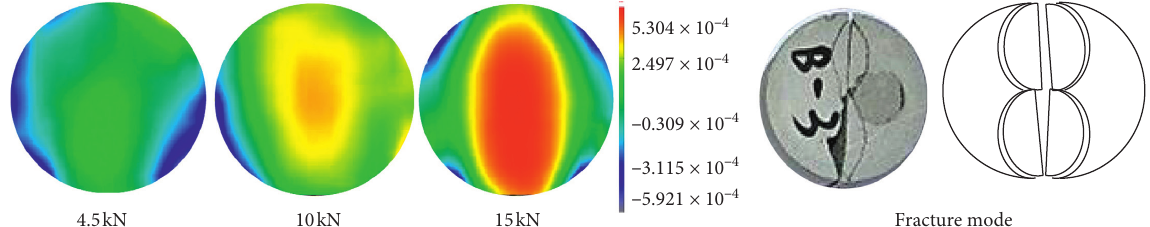
Figure 9: The evolution of the tensile strain ε xx fracture mode (taking sample B-3 as an example) at different loading stages (4.5MPa, 10MPa, and 15